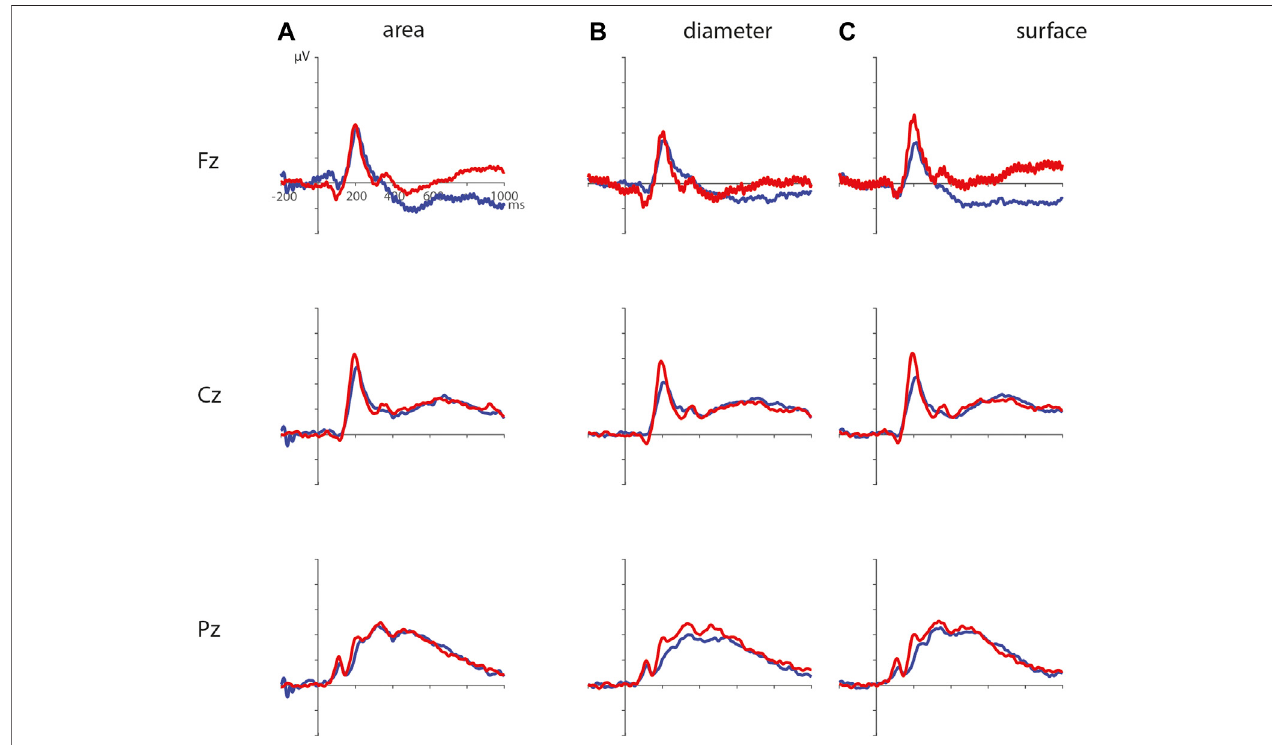
FIGURE 5 | ERPs for the different visual features with small area (A) , diameter (B) , and surface (C) in blue, and large area, diameter, and surface in red.